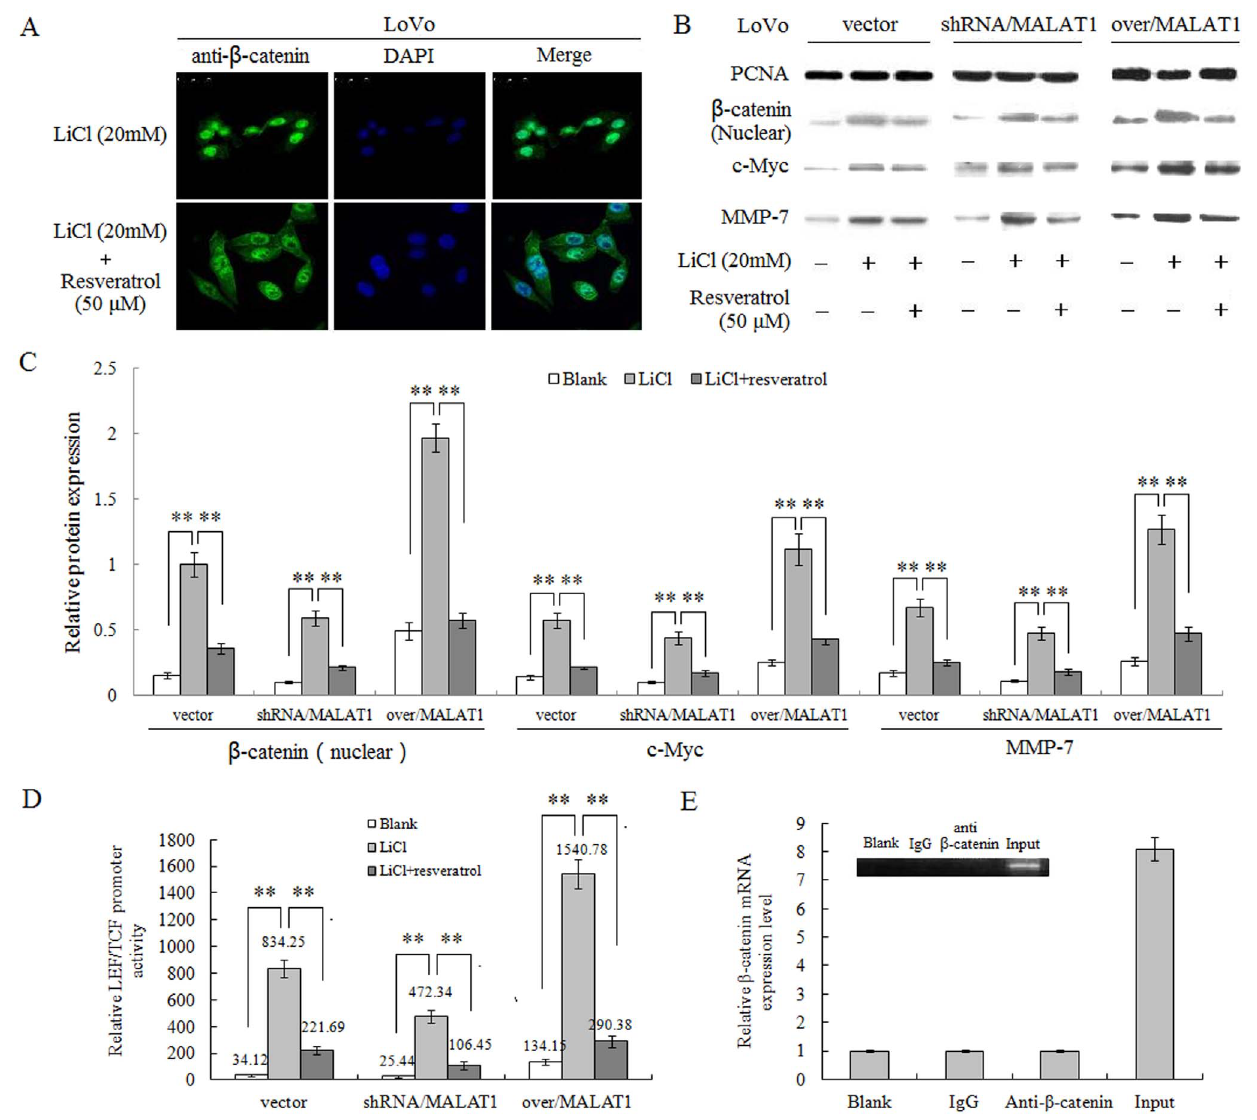
Figure 7. Resveratrol inhibits the Wnt/ b -catenin signaling through regulating MALAT1. (A): Resveratrol negated LiCl induced nuclear translocation of b -catenin. Immunofluorescence staining of b -catenin in LoVo cells treated with LiCl, with or without resveratrol. (B): Nuclear extracts from LoVo cells expressing MALAT1-shRNA, MALAT1-overexpressed, empty vector, treated with LiCl with or without resveratrol, were probed for b - catenin, c-Myc, MMP-7. (C): Quantification of b -catenin, c-Myc, MMP-7 protein levels from the data shown in (A). ** p , 0.01, compared with blank group or LiCl alone group. (D): The relative LEF/TCF promoter activities in LoVo cells expressing MALAT1-shRNA, MALAT1-overexpressed, empty vector, treated by LiCl, with or without resveratrol. ** p , 0.01, compared with blank group or LiCl alone group. (E): No interaction between MALAT1 and b -catenin. Insert: RT-PCR result showing amount of RNA pulled-down by RNA-binding protein immunoprecipitation. As negative controls, no cDNA (blank) or IgG alone was used. Lower pane: quantification result of the